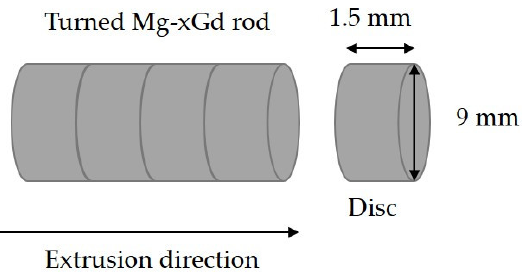
Figure 1. Charting of an extruded Mg- x Gd rod after machining to a diameter of 9 mm. Discs in cylindrical form with a diameter of 9 mm and a height of 1.5 mm were cut off by milling.